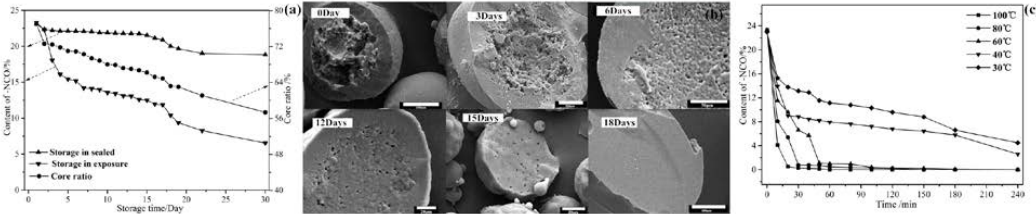
Figure 6. The change of –NCO content and the core ratio of microcapsules for different time ( a ). Scanning electron microscope (SEM) images of microcapsules at different storage time ( b ). The change of the –NCO content of microcapsules was immersed for different time and temperature ( c ).